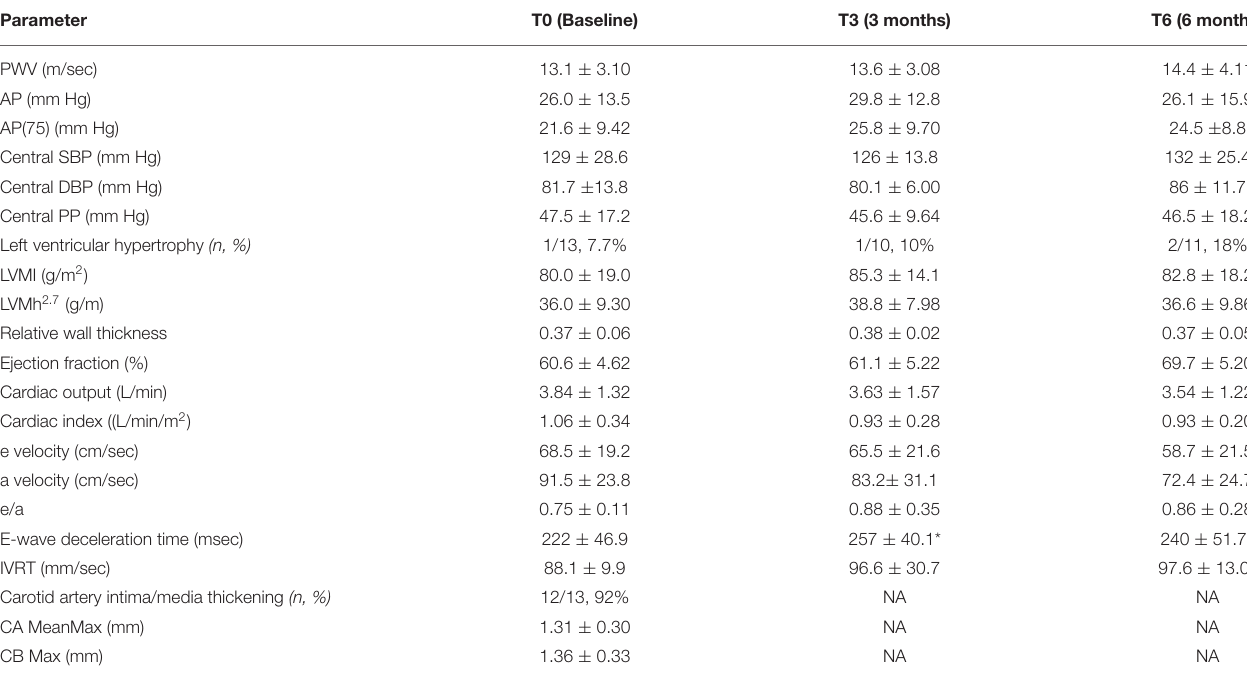
TABLE 4 | Large artery distensibility and cardiovascular parameters at the different time points. Parameter